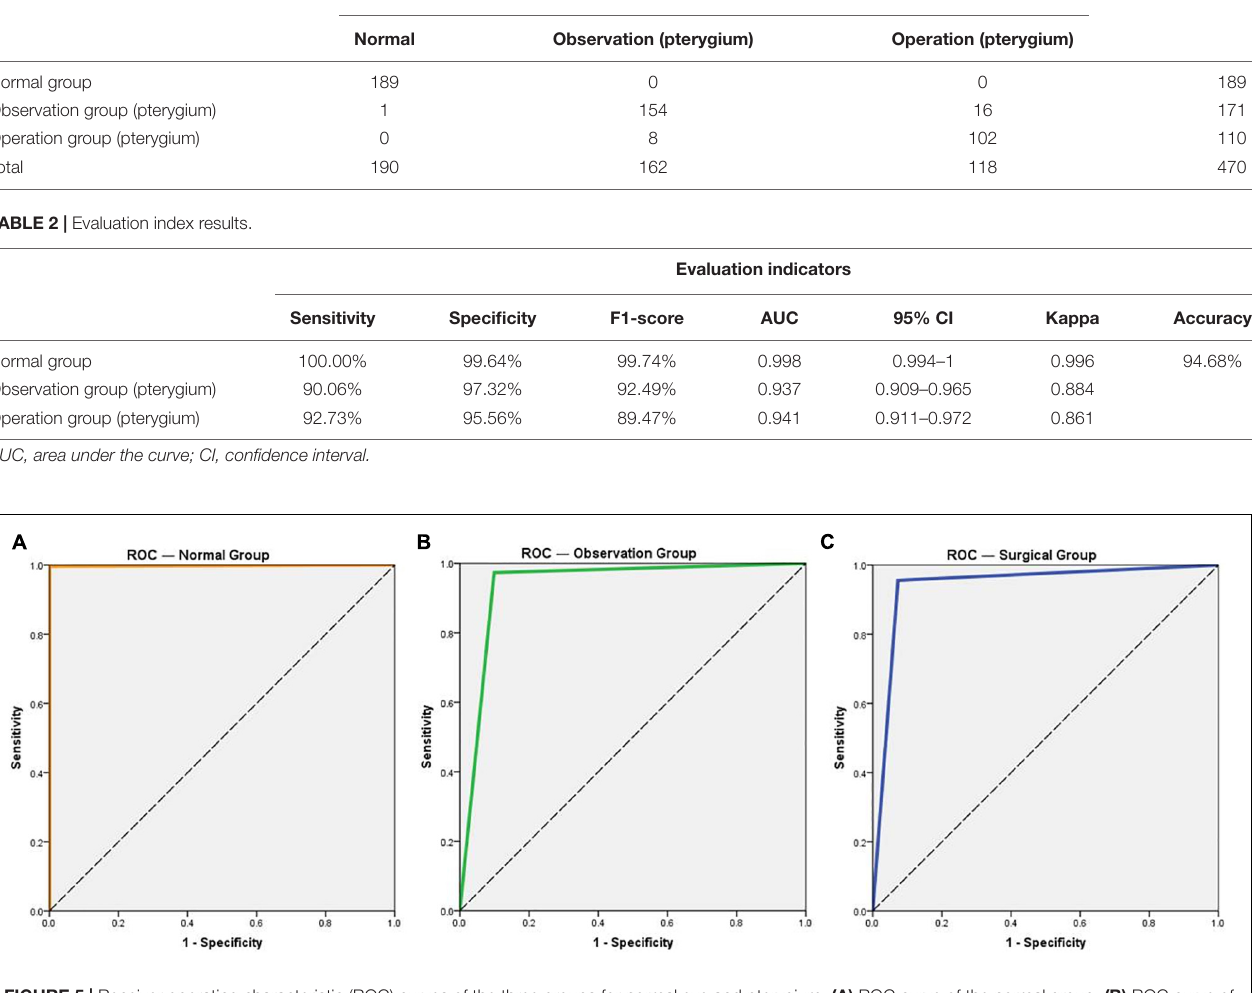
FIGURE 5 | Receiver operating characteristic (ROC) curves of the three groups for normal eye and pterygium. (A) ROC curve of the normal group. (B) ROC curve of the observation group. (C) ROC curve of the operation